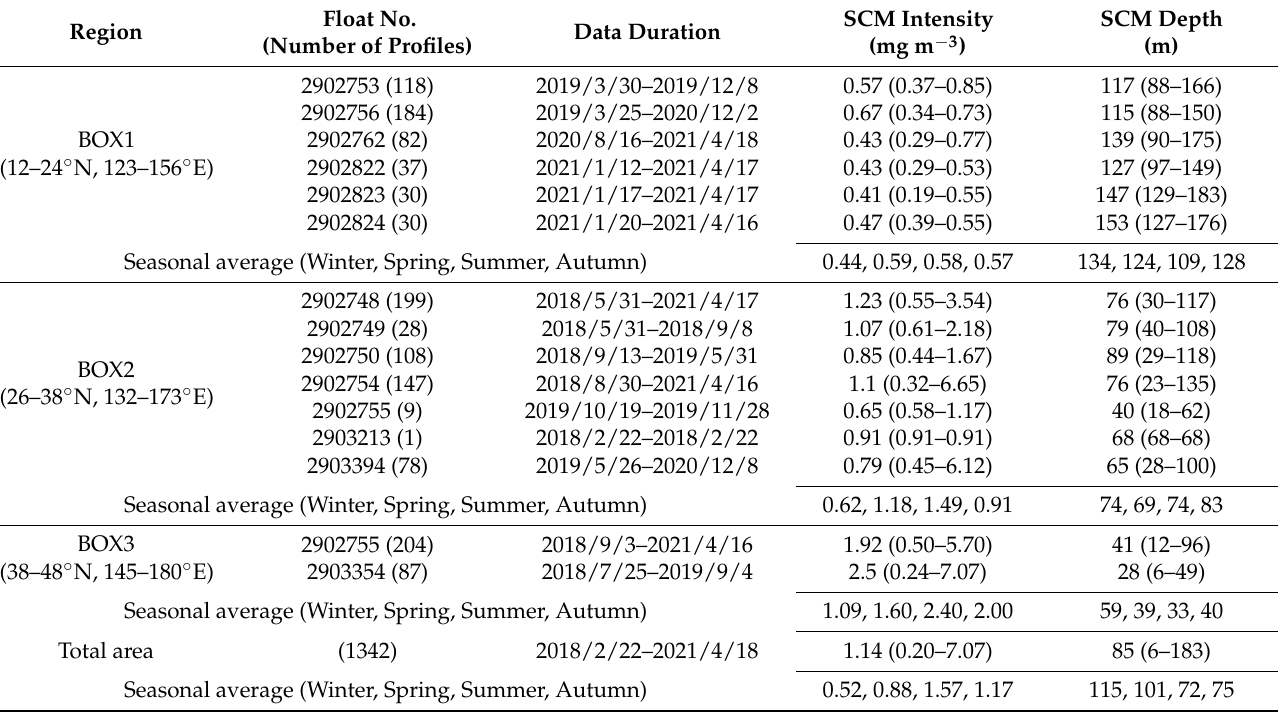
Table 1. Averaged intensity and depth of SCM in BGC-Argo database used